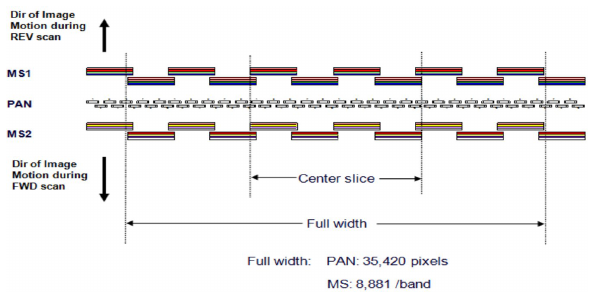
Figure 3: Focal plane assemblies of WorldView-2 (sketch cour- tesy Digital Globe)